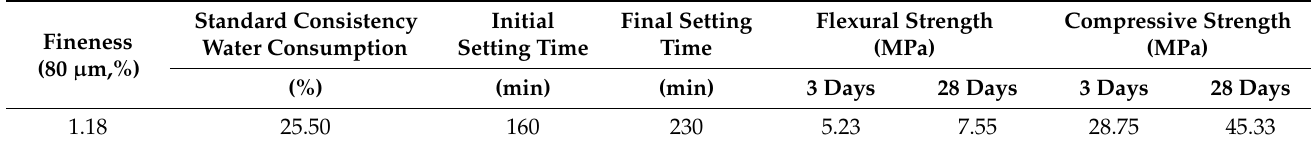
Table 2. Basic parameters of 42.5R ordinary Portland cement.